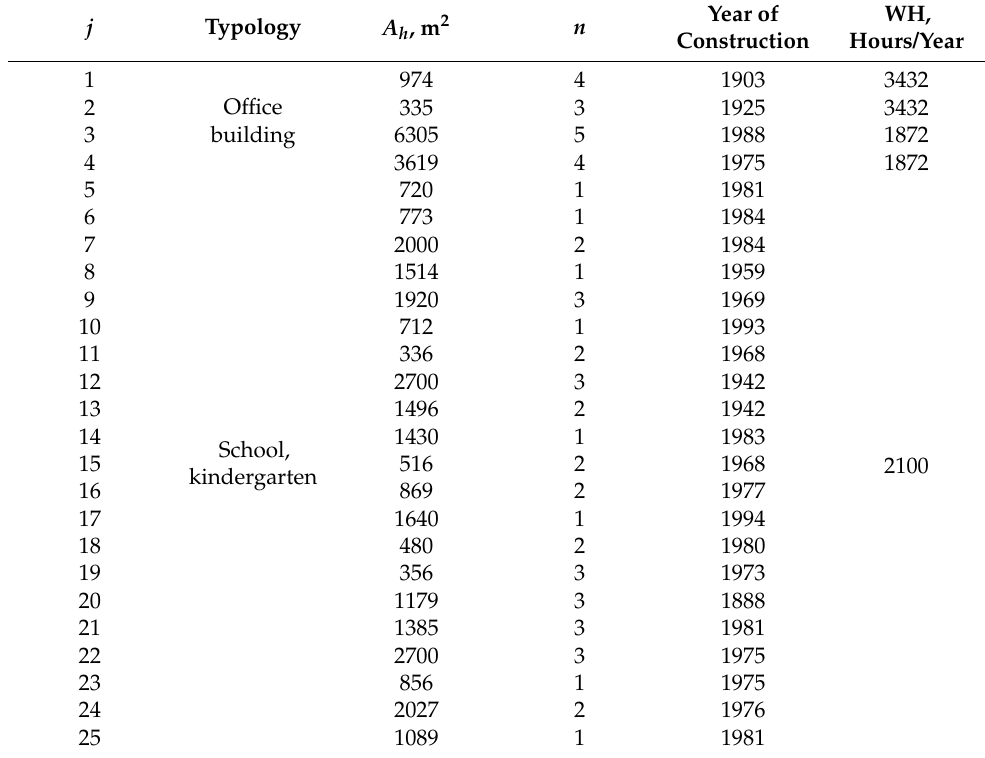
Table A1. Basic characteristics of buildings. A h = total heated area (m 2 ), j = building number (1 to 25), n = number of floors, WH = working hours per year [1].